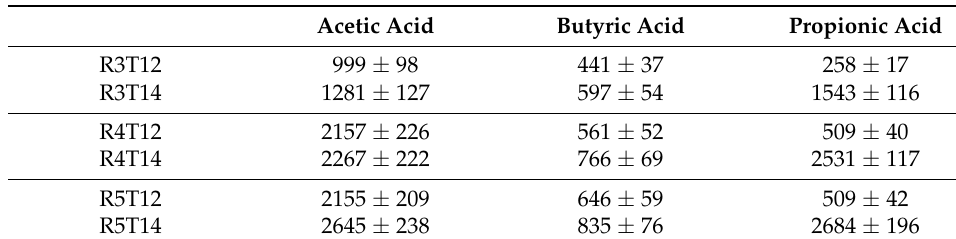
Figure 1. Microbiological count of the three colonic reactors: ( R3 , R4 and R5 ) before (T12) and after the treatment (T14) ( n = 2 ± SD). A Mann–Whitney U Test was applied for differences between two groups on a single, ordinal variable with no specific distribution. Different letters mean statistically significant differences: a, no significant difference ( p > 0.05) and c, for a very significant difference ( p < 0.025). Results are shown as log (CFU/mL).